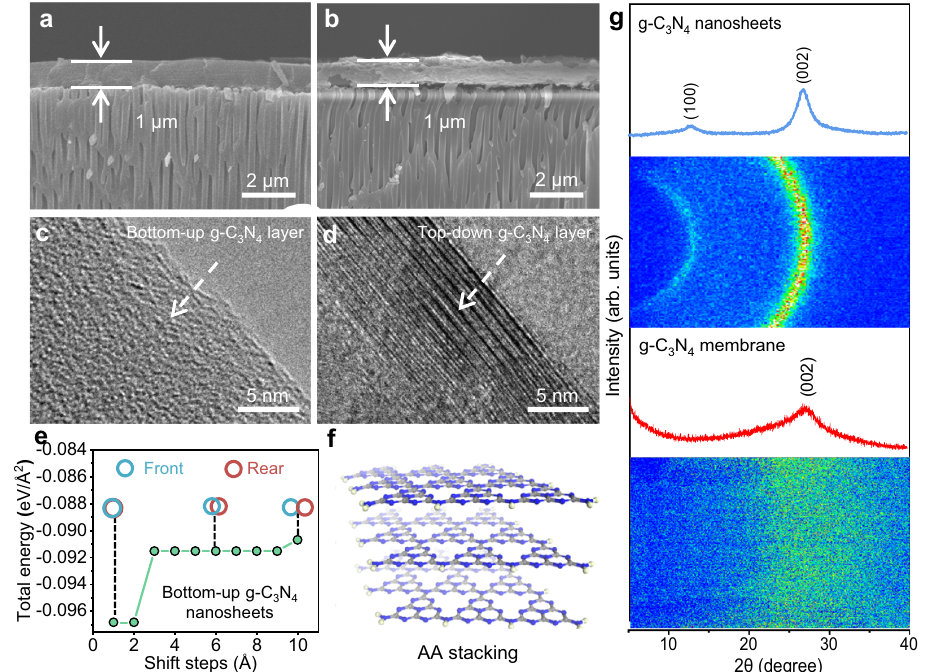
Fig. 2 | g-C 3 N 4 nanosheets membranes with disordered layer-stacking struc- ture. Cross-sectional SEM images of the a bottom-up g-C 3 N 4 and b top-down g- C 3 N 4 membranes. Cross-sectional TEM images of the c bottom-up g-C 3 N 4 and d top-down g-C 3 N 4 membranes. e The DFT calculations about stacking states of bottom-upg-C 3 N 4 nanosheetsing-C 3 N 4 membranes.Thefrontrepresentsthe fi rst layerof nanosheetin atwo-layersystemof g-C 3 N 4 andtherearrepresentsanother